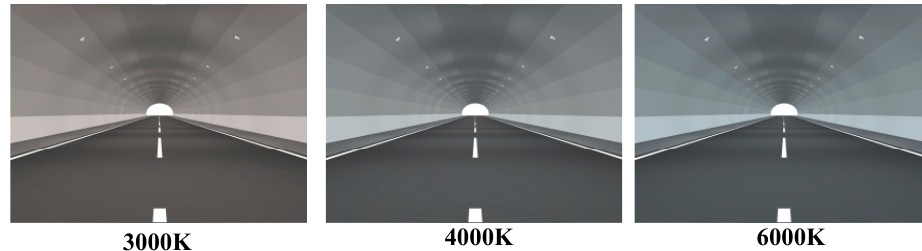
Figure 11. Simulation result and false-color image of road pavement.